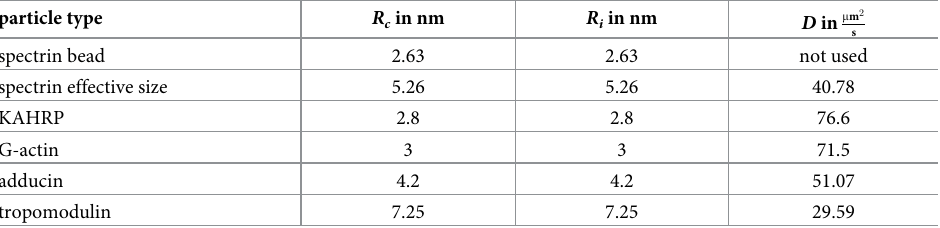
Table 1. Values for collision radii, reaction radii and diffusion